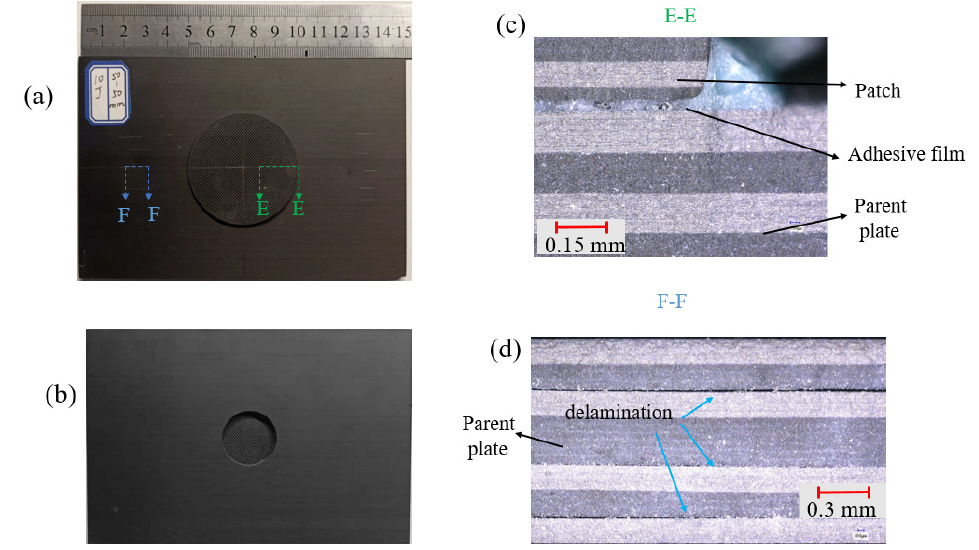
Figure 10. Micrographs of the patch-repaired specimen after the third impact at a distance of 50 mm: ( a ) the front part, ( b ) the back part, ( c ) E-E section and ( d ) F-F section.